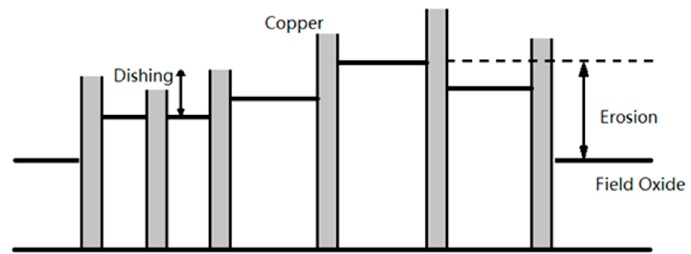
Figure 1. Illustration of dishing and erosion defects.